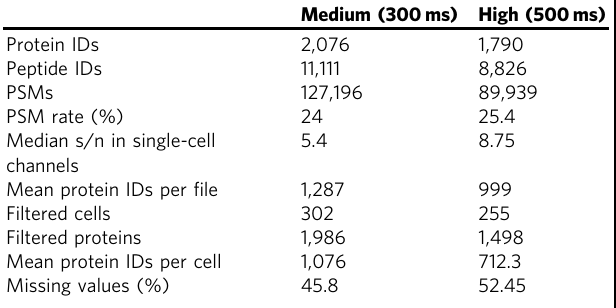
Table 2 Comparison of ‘ medium ’ and ‘ high ’ method using single-cell samples.